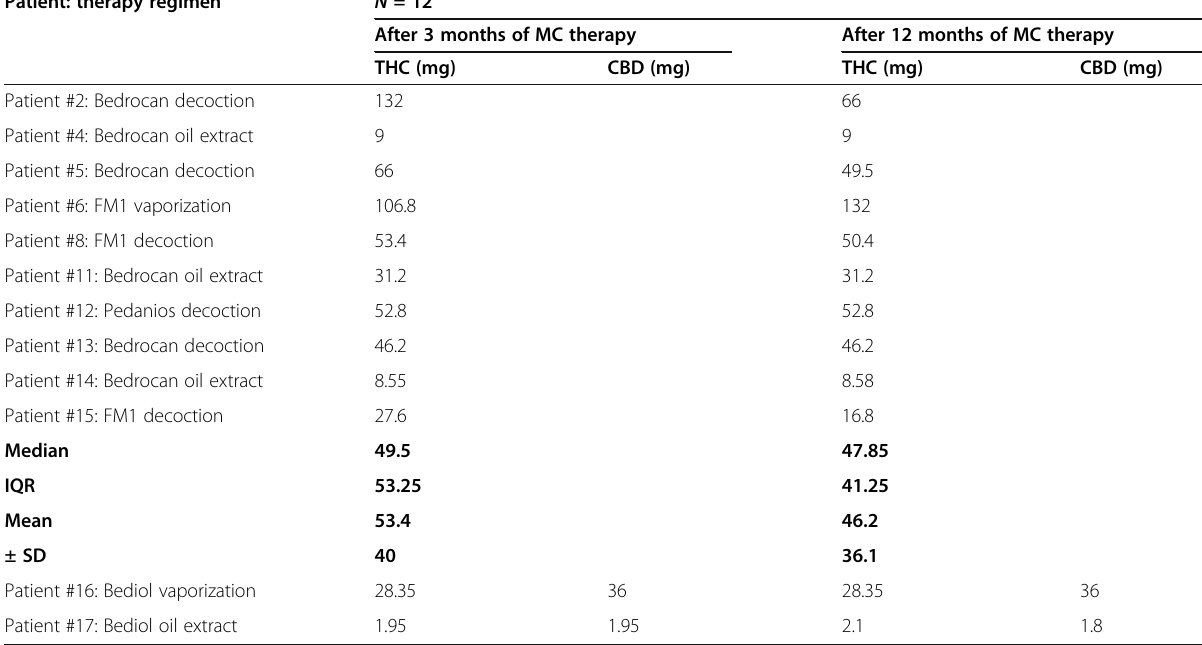
Table 13 Modification of MC dosage in 12 Italian fibromyalgia patients after 3 and 12 months of treatment Patient: therapy regimen